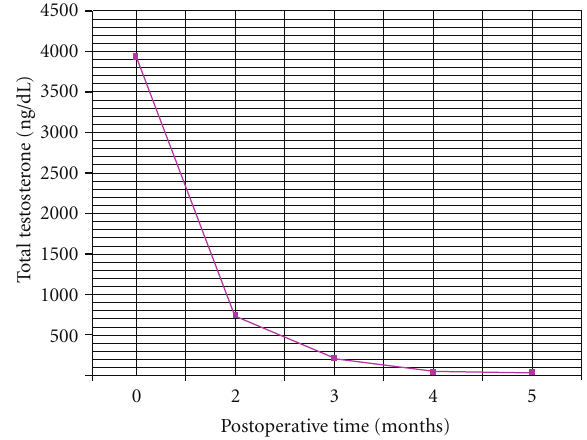
Figure 3: Total testosterone levels versus postoperative time. Note the abrupt reduction in the total testosterone level in the immediate postoperative